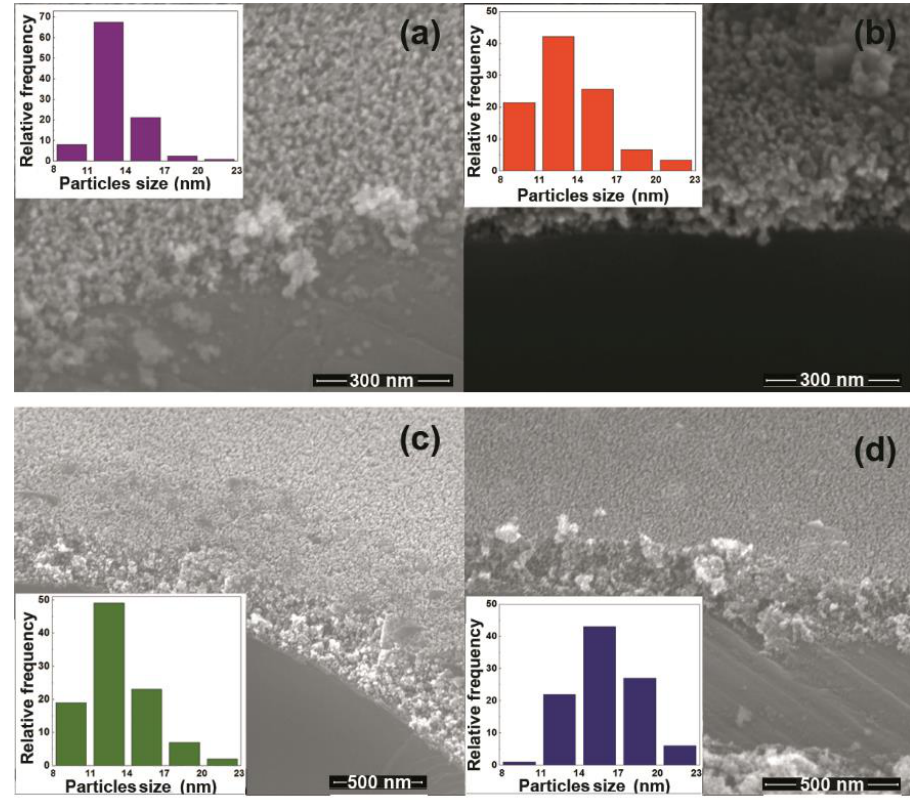
Figure 3. SEM images of surface and particles size distribution in ZnO-SnO 2 films: ZnO ( а ), Sn:Zn